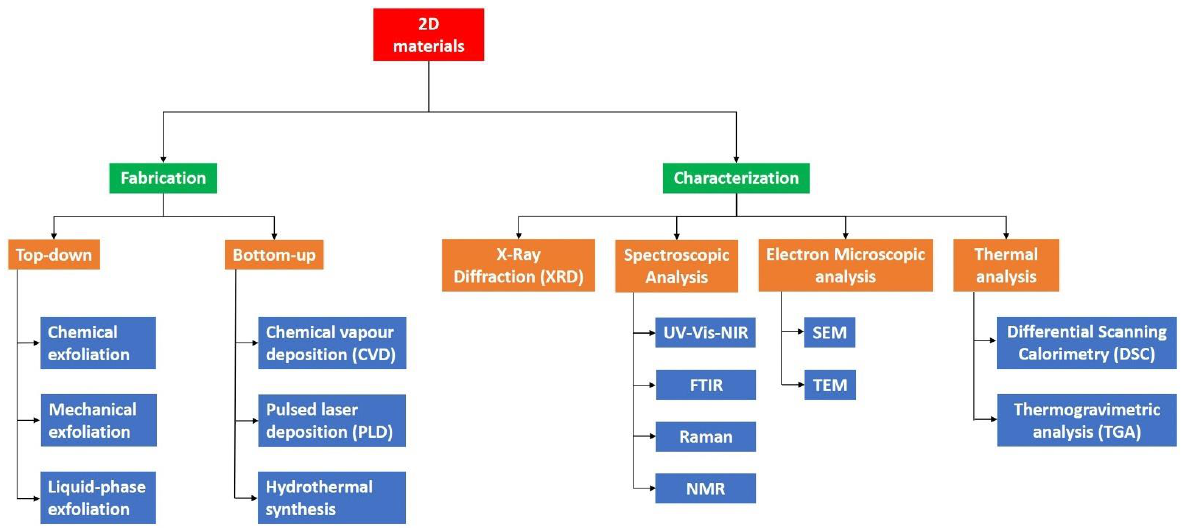
Figure 6. Typical fabrication and characterization methods for 2D TMD